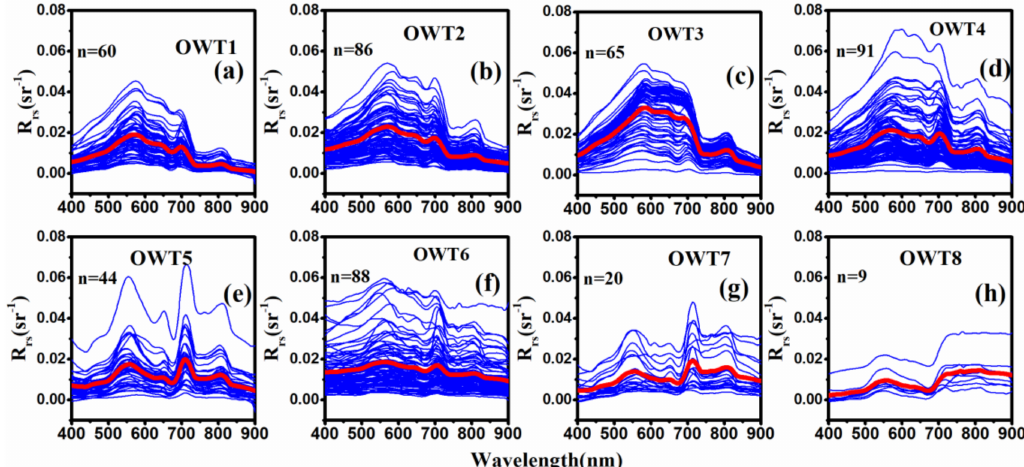
Figure 3. Spectral curves of each OWT ( a – h ). The thin blue curves are R rs measured in situ and the red bold curves are the mean R rs of each